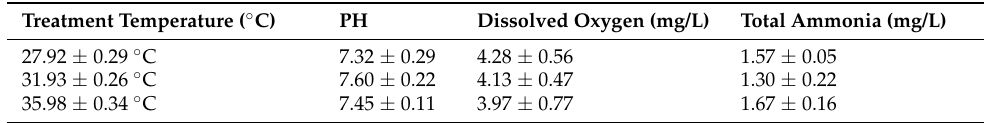
Table 1. Water quality parameters of temperature, PH, dissolved oxygen, and total ammonia. Data are presented as means ± standard error of mean (SEM). Three biological replicates were set for each temperature